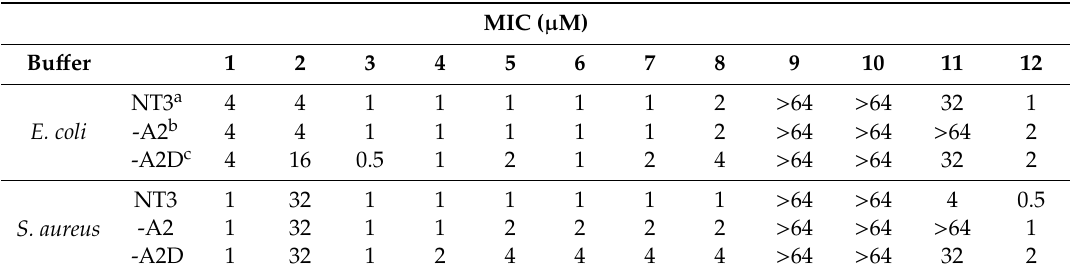
Table 2. Comparison of antimicrobial activities of peptides against E. coli and S. aureus under various physiological conditions.